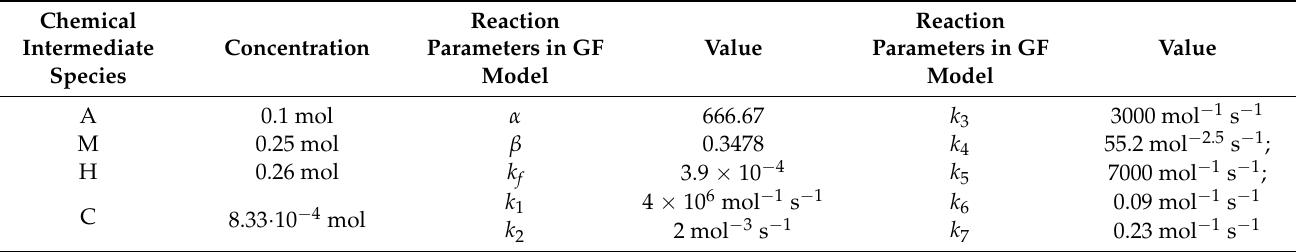
Table 1. The concentrations of intermediate species and the values of reaction parameters in the GF model for chaotic behavior at low flux.